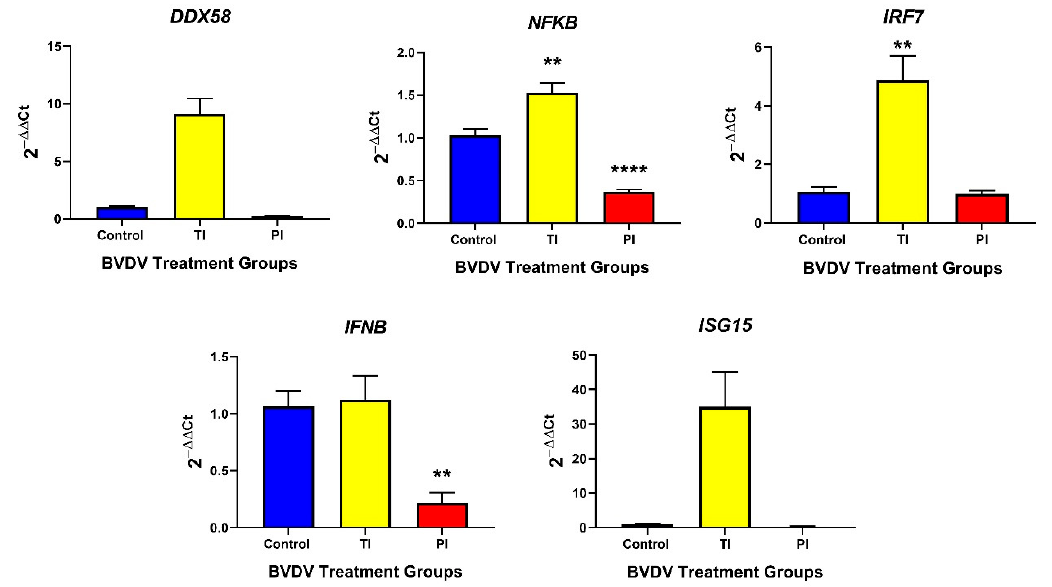
Figure 2. Control, TI, and PI thymus transcripts associated with the innate immune response. Interferon transcriptional regulators NFKB and IRF7 were significantly upregulated in TI fetuses compared to controls. In PI fetal thymuses, only IFN transcriptional regulator NFKB and IFNB were down-regulated compared to control fetuses. TI: Transiently Infected, PI: Persistently Infected, ** p < 0.01, **** p < 0.0001.